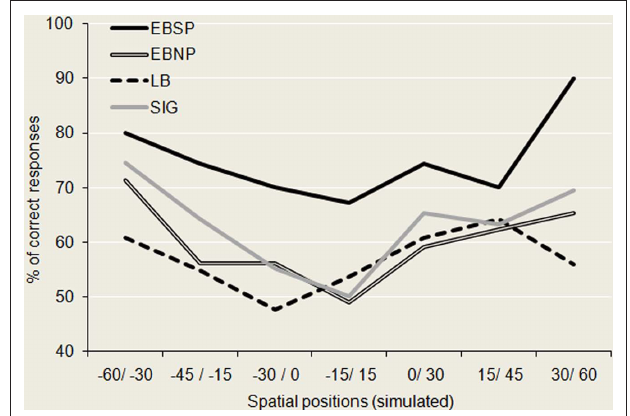
FigurE 2 | Behavioral performance for the spectral discrimination task. Here are plotted the performance of each group across the different azimuthal regions tested. The EBSP group significantly outperformed all other groups while all other comparisons were non-significant. Noteworthy is the finding that performance is best for spectral cues corresponding to peripheral positions, for all groups, consistent with the notion that spectral cues are most beneficial for peripheral auditory space in the